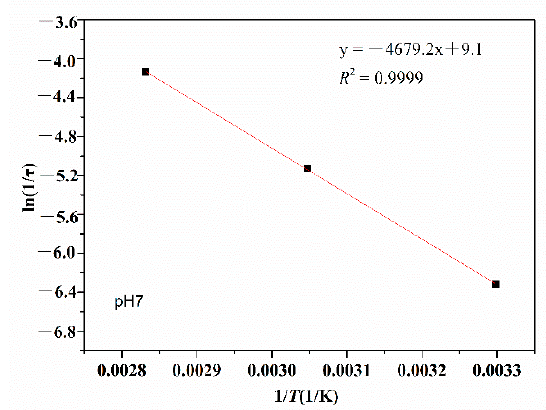
Figure 6. Exponential viscosity decay plots at pH 7.